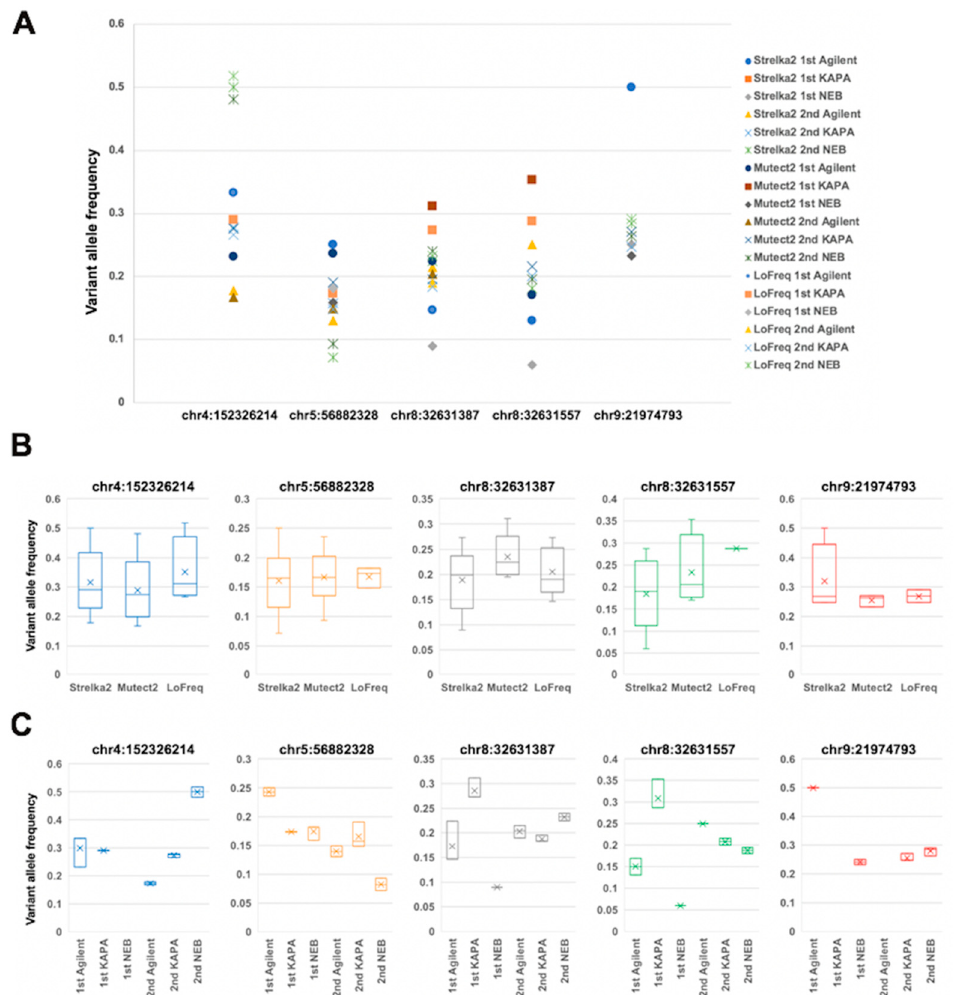
Figure 5. Comparison of variant allele frequency between dual deep sequencing. ( A ) Variant allele frequency of detected variants for each somatic variant caller in each sequencing experiment with the three DNA polymerases. ( B ) Variant allele frequency for each somatic variant caller. ( C ) Variant allele frequency for each sequencing experiment with the three DNA polymerases.